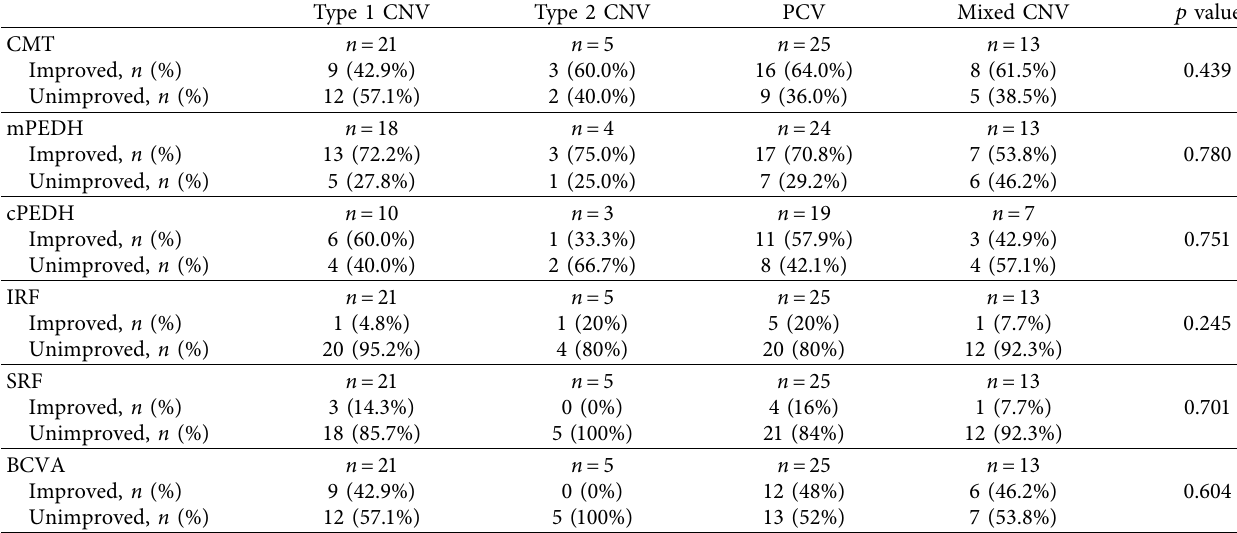
Figure 7: Changes in proportion of patients have SRF on SD-OCT. The proportion of patients with SRF did not change significantly before and after switching. SRF, subretinal fluid; IVC, intravitreal injections of conbercept; IVB, intravitreal injection of bevacizumab; IVR, intravitreal injection of ranibizumab; T0, baseline visit; T1, 1 month after the first ICV; T2, 1 month after 3 monthly IVC; T3, 1 month after the first IVR or IVB; T4, 1 month after the last IVR or IVB. Table 2: The proportions of improved response stratified by CNV type at 1 month after